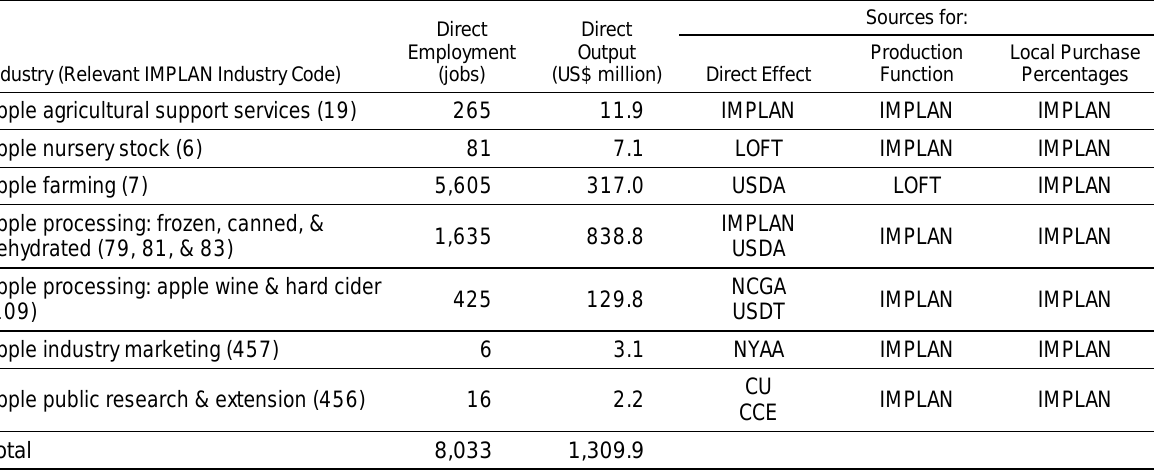
Table 1. Level of Direct Effects and Sources of Data, New York Apple Industry, 2016 Dollars